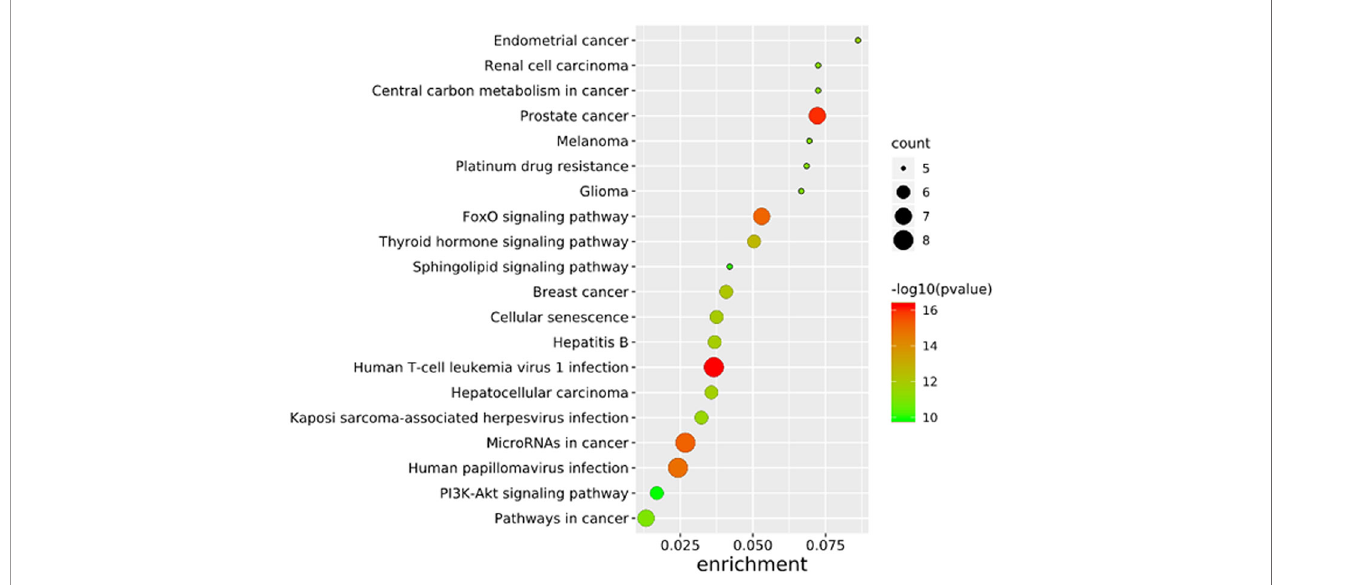
FIGURE 5 | Pathways enrichment map of important